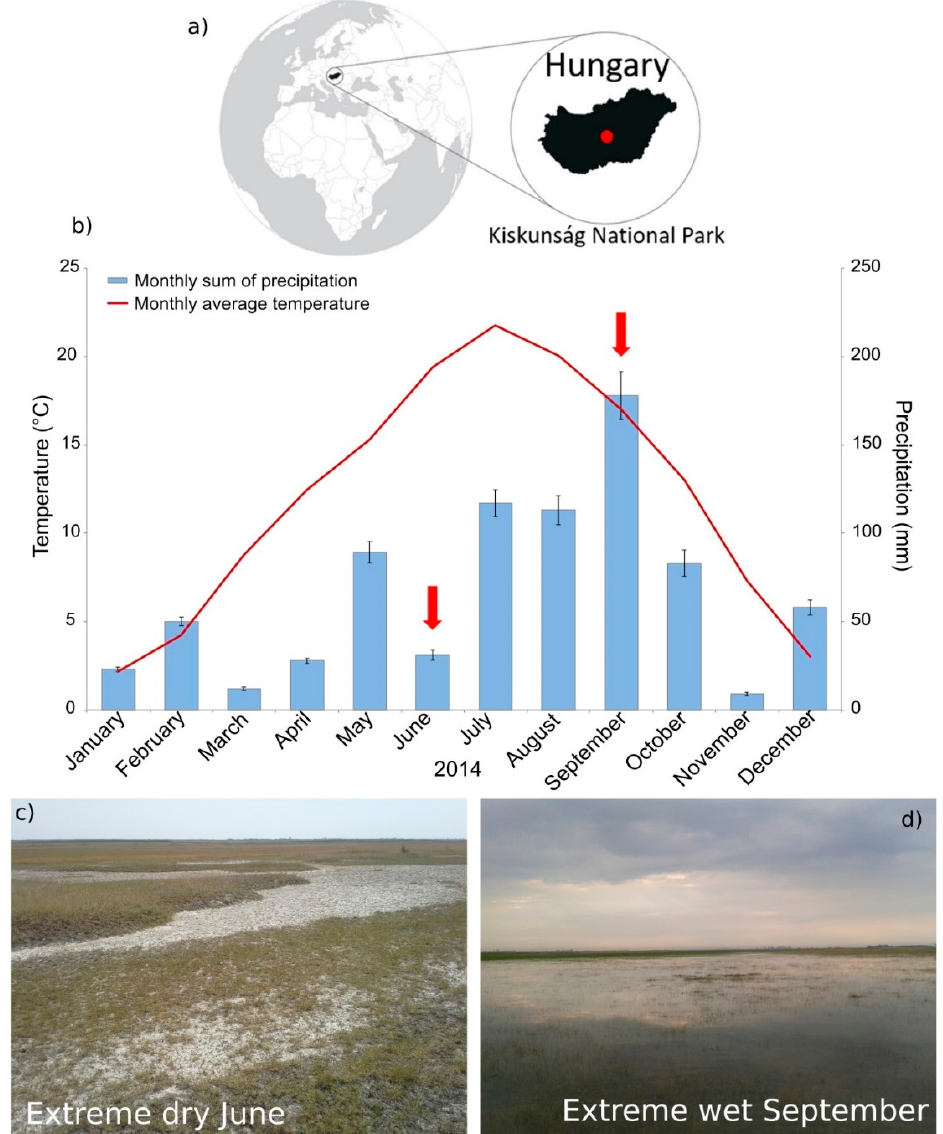
Figure 1. ( a ) Location of sampling sites in Europe and in the area of Kiskunság National Park, Hungary. The maps in the figure were redrawn after Anda et al. 2020 [18]. ( b ) Changes in weather conditions in the year of sampling based on monthly average air temperature (°C) and monthly sum of precipitation (mm) in the Pannonian steppe, Kiskunság NP, Hungary (Red arrows mark sampling dates.). Error bars show the standard deviations calculated from the daily differences of precipitations. Data obtained from the public database of the Hungarian Meteorological Services. Photos show the Puccinellia sward sampling site AP during ( c ) the extreme dry June and ( d ) the extreme wet September. Table 1. Sampling sites, geographical coordinates and vegetation characteristics.